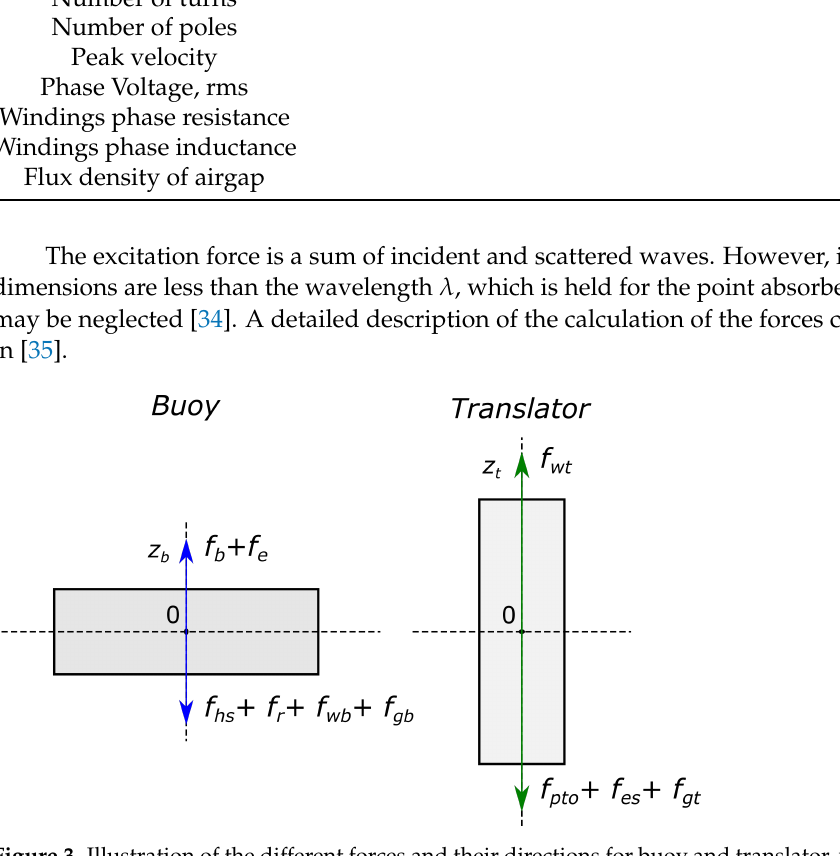
Figure 3. Illustration of the different forces and their directions for buoy and translator, where origins of the coordinate system are the center of